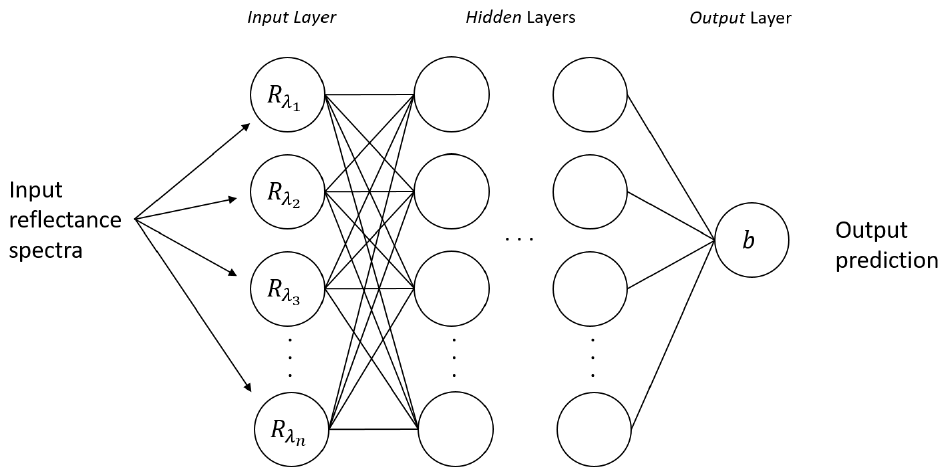
Figure 5. Multi-Layer Perceptron model for blood stain reflectance spectra binary